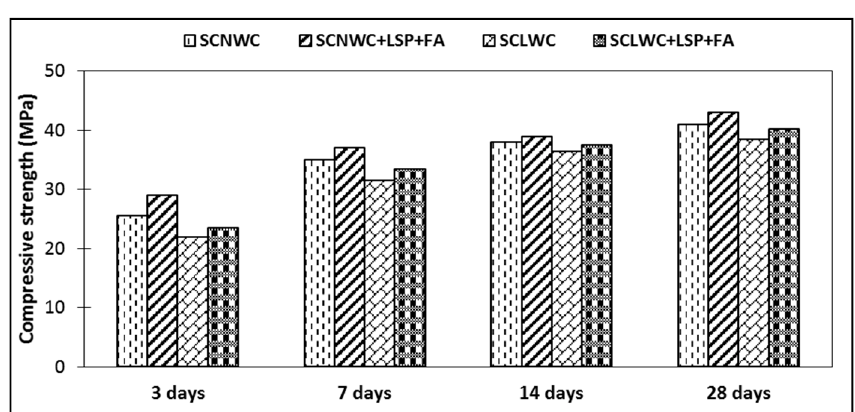
Figure 4. Compressive response of the concretes.